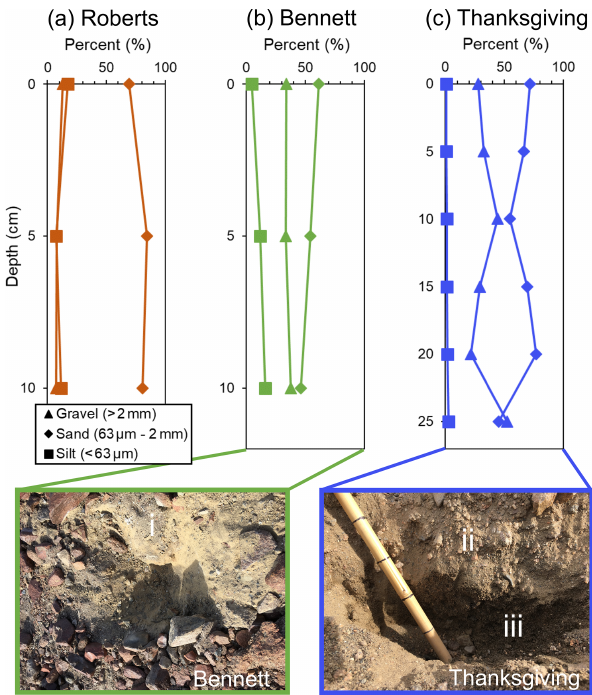
Figure 4. The grain size composition of soil profiles collected from Roberts Massif ( a , orange), Bennett Platform ( b , green), and Thanksgiving Valley ( c , blue). The soil pits from Bennett Platform and Thanksgiving Valley are also shown with distinct soil hori- zons. The different soil horizons observed at Bennett Platform and Thanksgiving Valley are indicated by i, ii, and